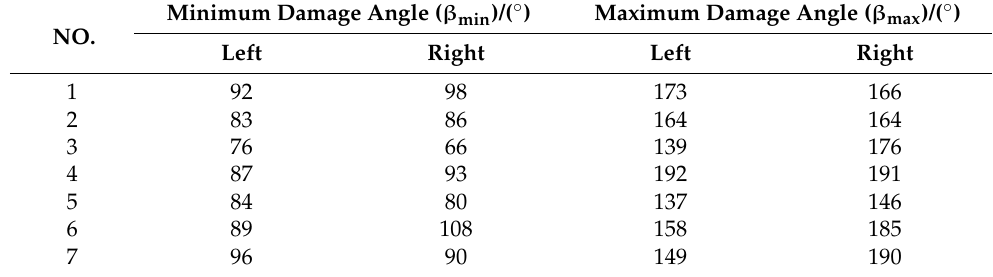
Table 4. Angle of tooth mark